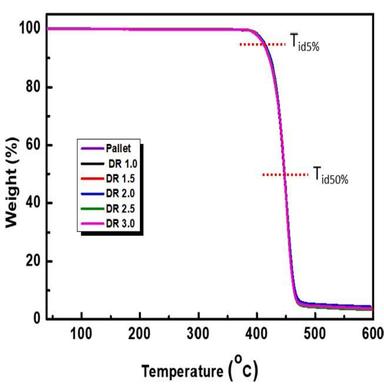
TGA thermograms of the developed biaxially oriented PCTN copolymer films.